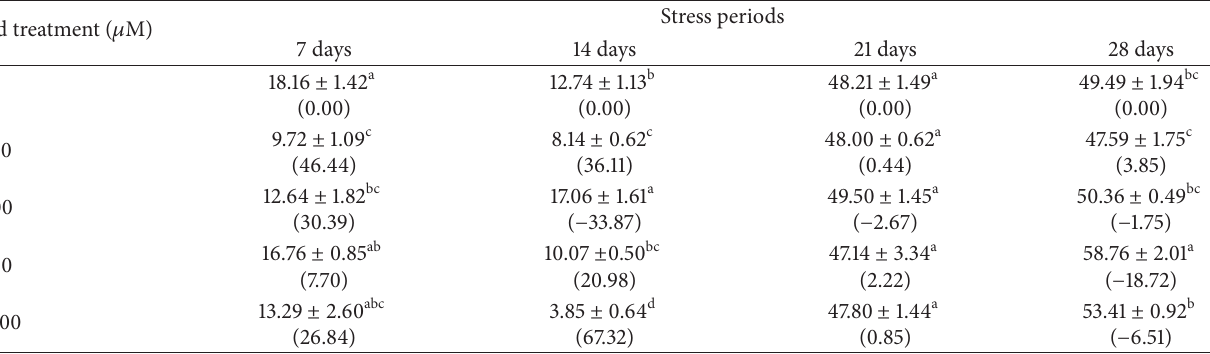
Table 8: APX activity ( 𝜇 Mg − 1 FW) of cotton callus culture (cv. YZ1) grown under various levels of cadmium. Cd treatment ( 𝜇